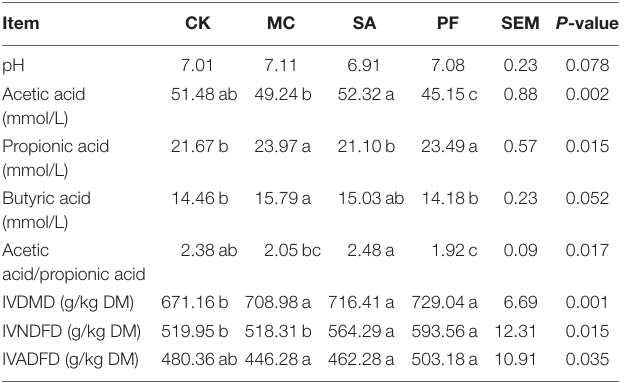
FIGURE 5 | Cumulative total gas emissions, CH 4 , and CO 2 production of paper mulberry silage after 75 days of ensiling during in vitro incubation. CK, without additives; MC, 5% mint; SA, 5% clove; PF, 5% purple perilla. a − cMeans with different superscripts are significantly different ( P < 0.05).